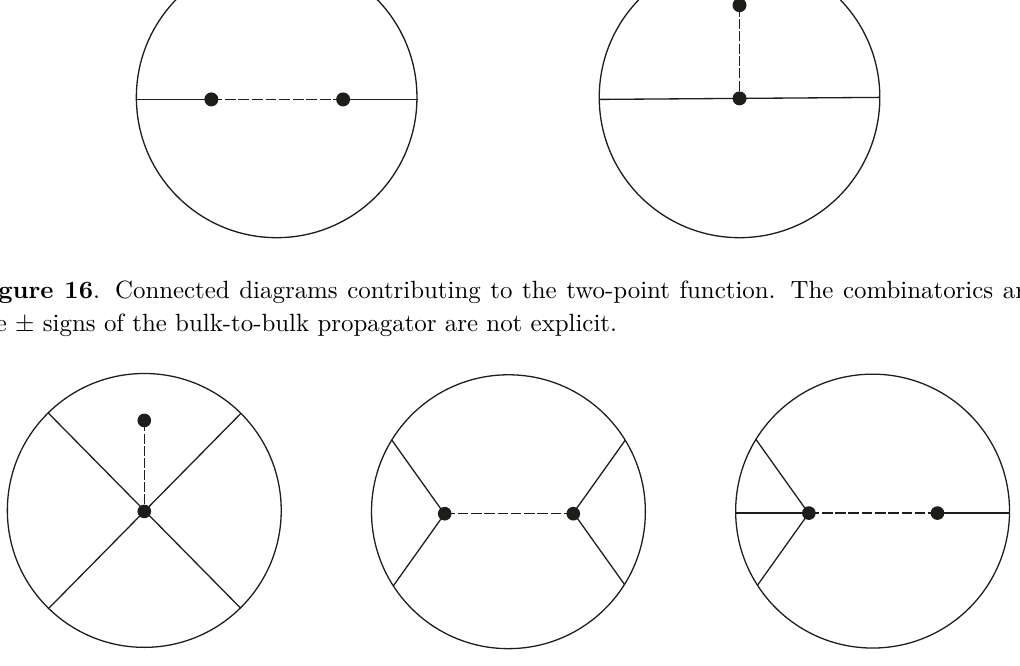
Figure 17 . Connected diagrams contributing to the four-point function. The combinatorics and the ± signs of the bulk-to-bulk propagator are not